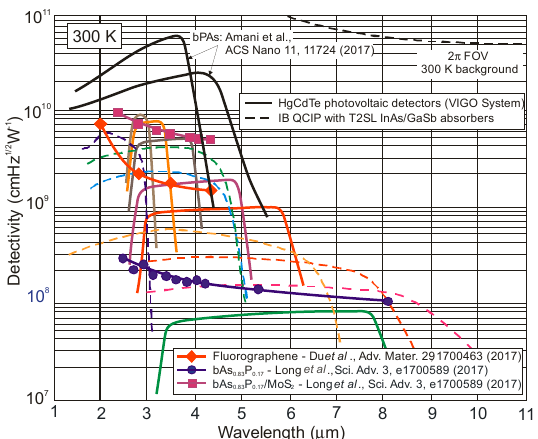
Figure 2. Comparison of spectral detectivity graphene-based detectors with commercial detectors.